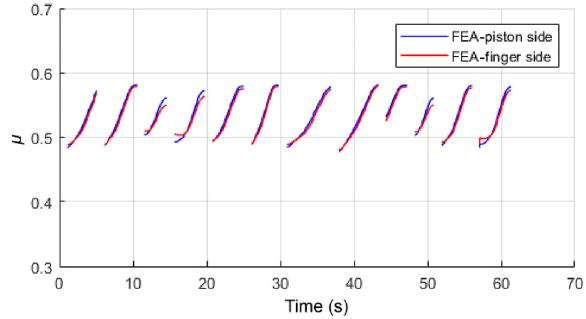
Fig. 8 Internal and external side friction coefficient.